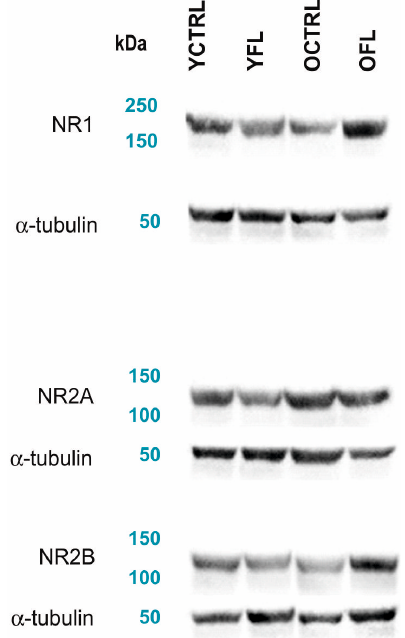
Figure 1. Expressions of N-methyl-D-aspartate receptor (NMDA) receptor subunits in the frontal cortex from both hemispheres in young adult and old rats exposed to forced locomotion. Optical density of respective NMDA subunit bands ( A – C ) related to that of α -tubulin. Results are presented as means ± SEM. Statistical significance (Student´s t -test) was calculated with respect to young adult or old controls (* p < 0.05, *** p < 0.001). FL—forced locomotion, YCTRL—young adult controls ( n = 8), YFL—young adult rats exposed to FL ( n = 10), OCTRL—old controls ( n = 8), OFL—old rats exposed to FL ( n = 9).